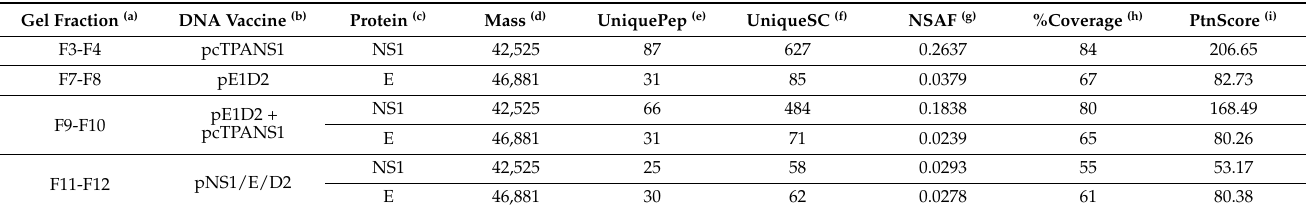
Table 1. Mass spectrometric identification of dengue virus proteins in the supernatant of BHK-21 cells transfected with different DNA